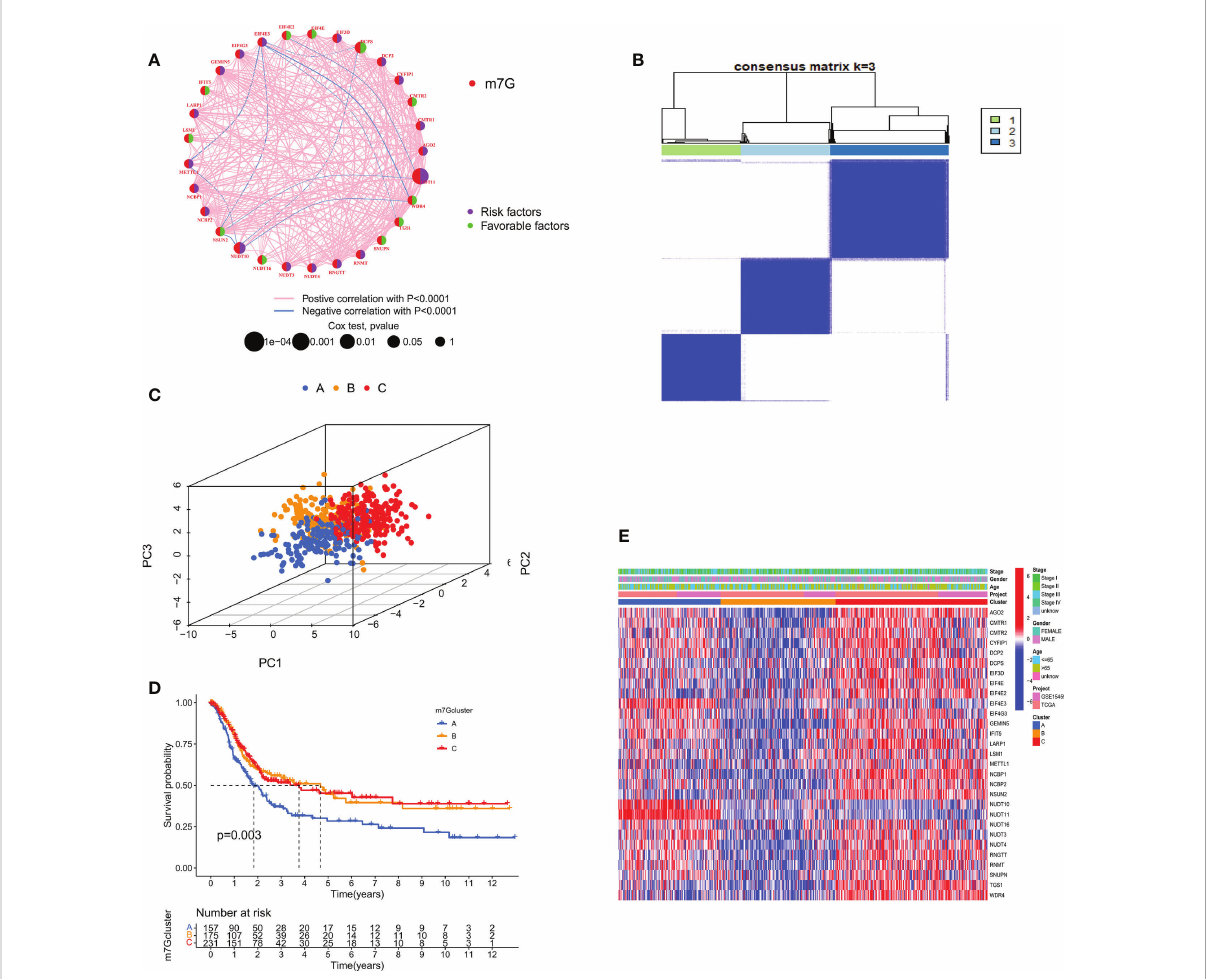
FIGURE 4 (A) Interaction between m7GRGs in GC. Connected lines indicate the existence of interactions between m7GRGs, and the thickness of the line indicates the strength of the association between m7GRGs. Pink and blue represent negative positive and negative correlations, respectively. (B) Consensus clustering analysis of three clusters (k = 3). (C) PCA showed signi fi cant differences among the three subtypes. (D) Kaplan-Meier curves for survival differences among the three subtypes. (E) Heat map of the analysis of differences among the three subtypes and correlation analysis between subtypes and clinicopathological features. PCA, Principal component